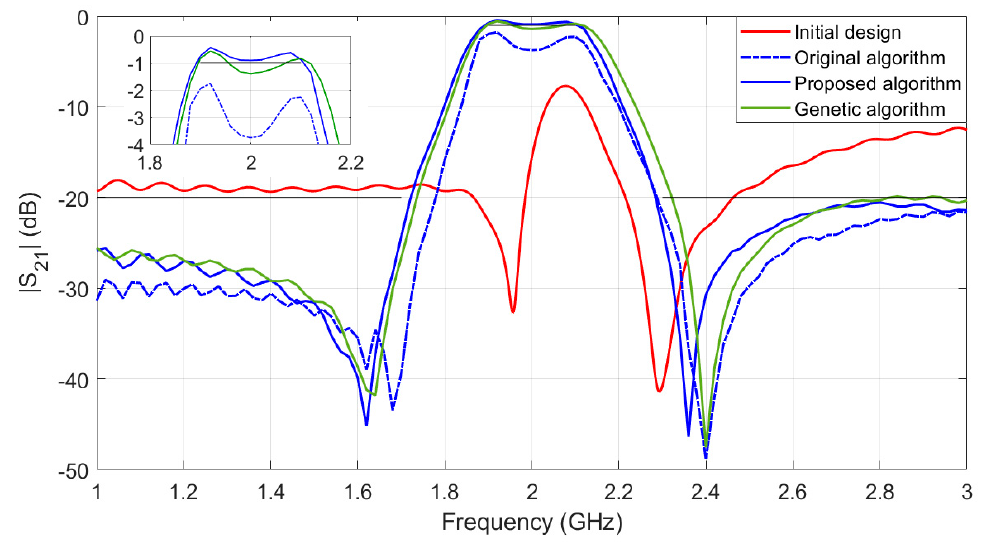
Figure 4. Second-order ring resonator bandpass microstrip filter: responses of the initial design and optimal designs obtained by various algorithms.